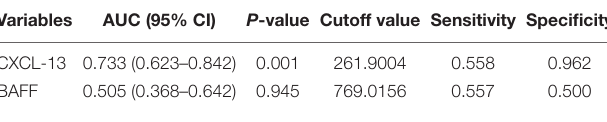
TABLE 6 | Receiver operating characteristic analysis results of different predictors for SCIT efficacy in validation